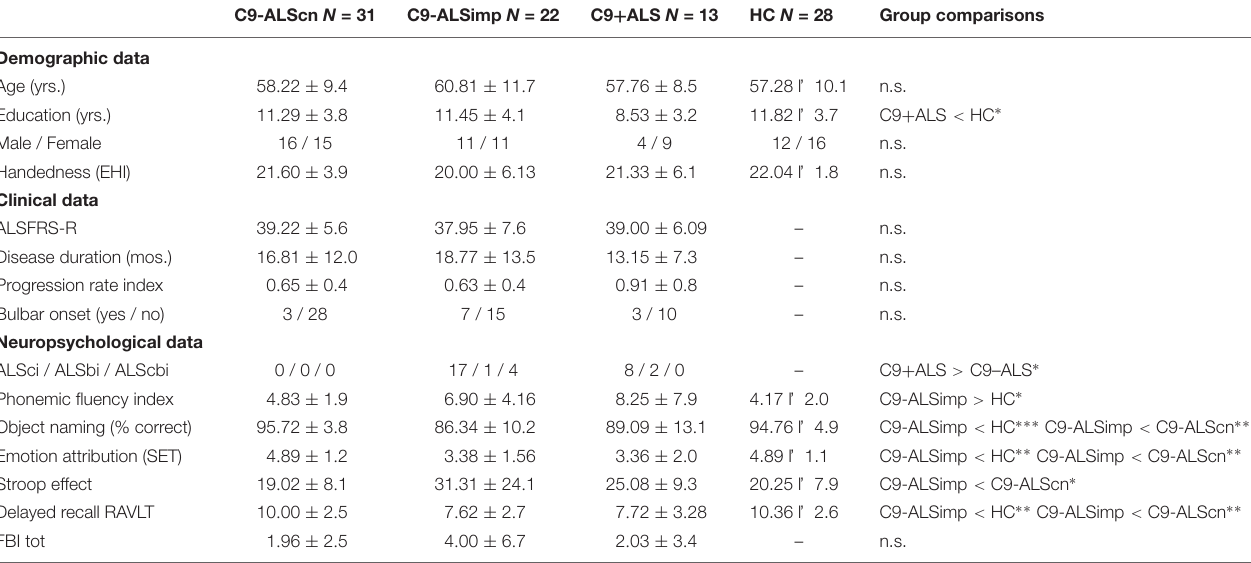
TABLE 1 | Demographic, clinical and neuropsychological data (mean ± standard deviation).